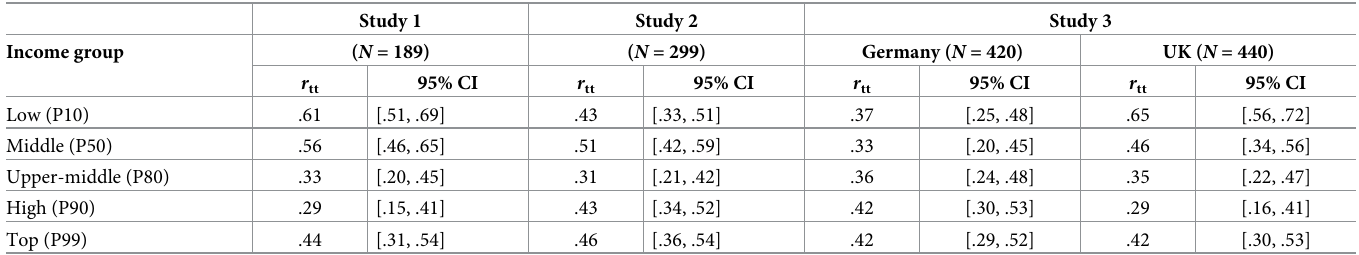
Table 4. Reliability estimates for the JEID items by